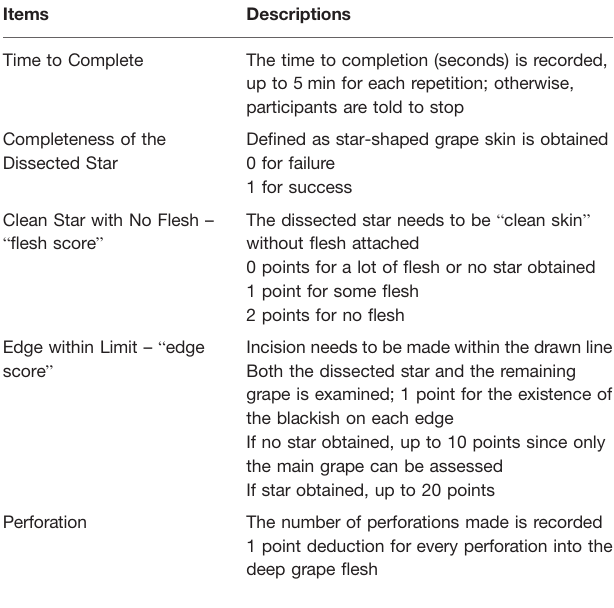
TABLE 1 | Microsurgical grape dissection task “ Star ’ s the limit ” grading